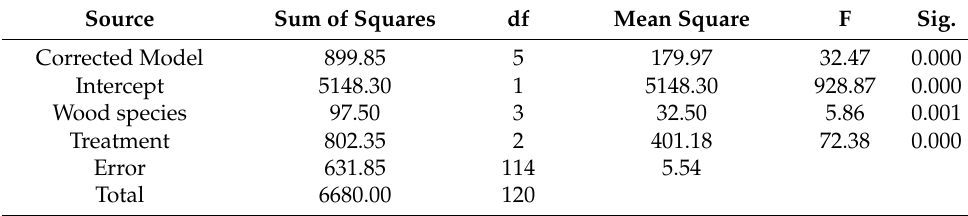
Table 14. Variance analysis of protection